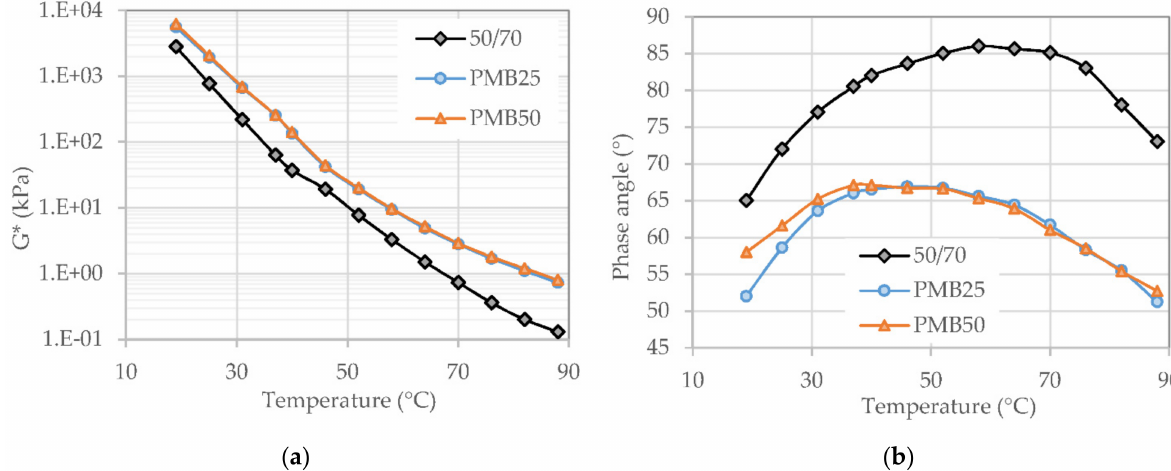
Figure 5. Rheological characteristics of the asphalt binders, i.e., the base bitumen 50/70, PMB with 2.5% SBS (PMB25), and PMB with 5.0% SBS (PMB50): ( a ) Complex shear modulus (G*); ( b ) phase angle ( δ